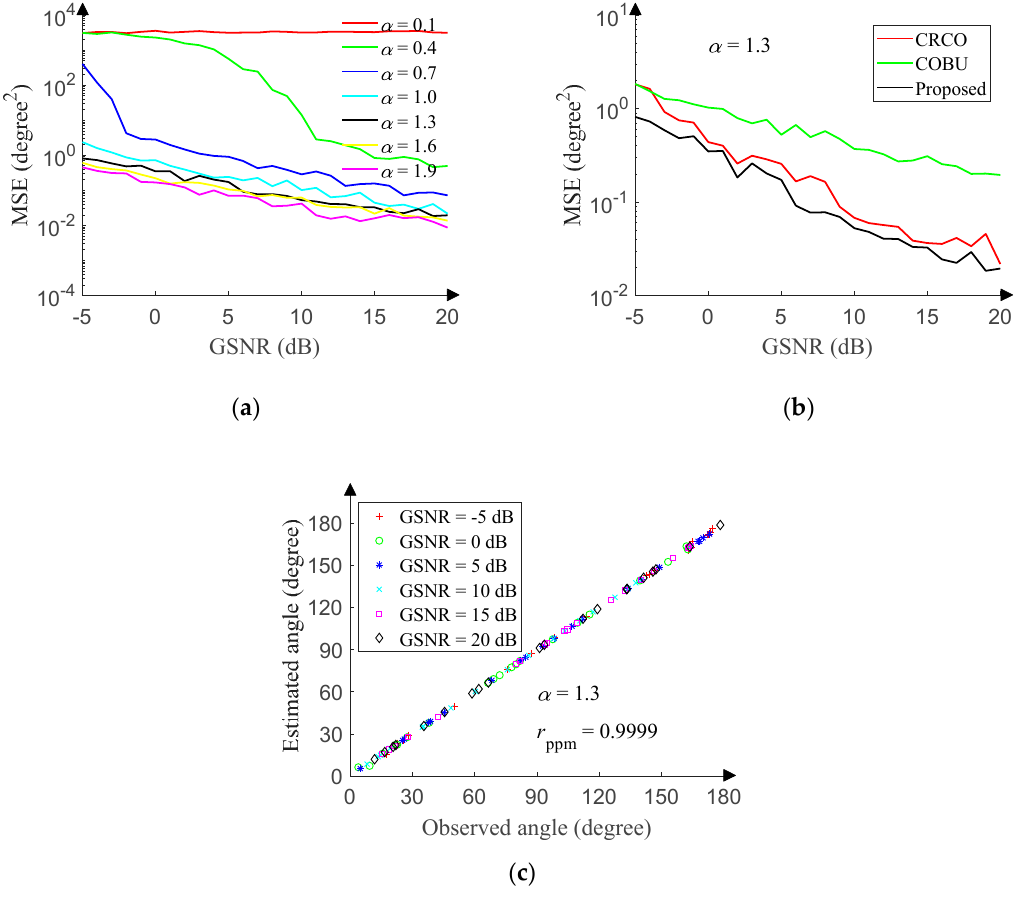
Figure 14. 1D-DOA network performance in non-Gaussian noise. ( a ) MSE versus GSNR. ( b ) MSE versus GSNR. ( c ) Angle correlation diagram.